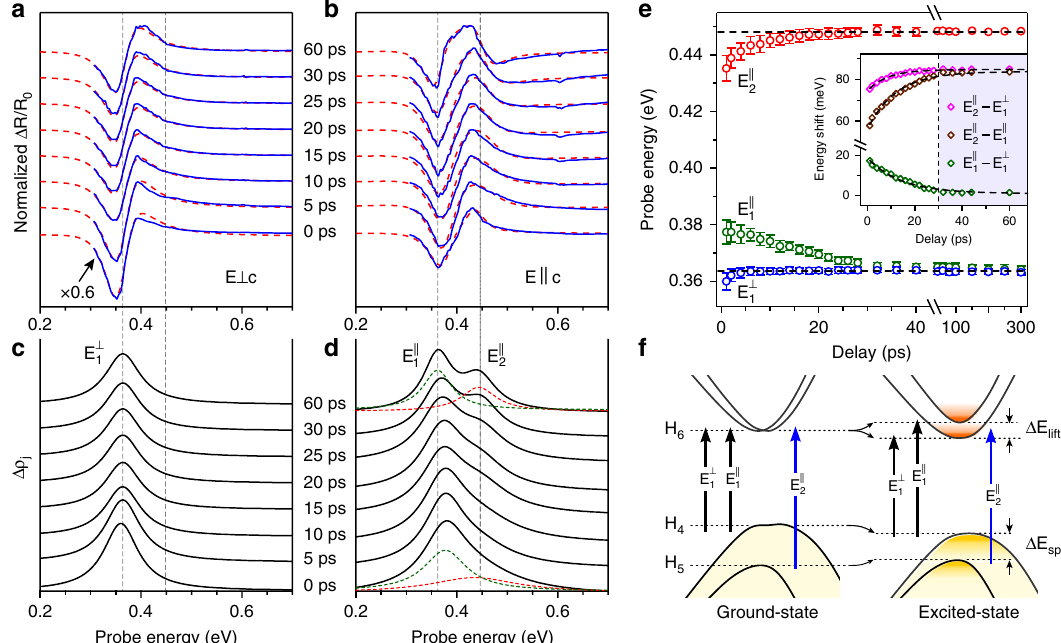
Fig. 3 Transient response of polarized optical transitions in Te nanosheet. a , b A series of selected TR spectra (blue lines) recorded at different pump- probe delay times for both E ? c and E jj c polarizations. Dashed red lines are model fi ts of each corresponding spectrum. c , d Moduli of each corresponding fi t for both polarizations. Vertical dashed gray lines are guides to the eye to indicate the systematic shift of peak position. e Transition energies E ? , E jj , and 1 1 E jj extracted from the fi ts and plotted as a function of delay for both polarizations. Error bars are estimated from the least square fi tting procedure. While 2 the E ? remains mostly stable over a long delay, the E jj , and E jj undergo gradual blue and redshifts as delay progresses before they remain steady after ~30 1 1 2 (cid:2) E ? (cid:2) E ? ps. The inset shows the time evolution of anisotropic spectral shifts, as quanti fi ed by E jj and E jj for fundamental and higher energy band-gap 1 1 1 2 (cid:2) E jj anisotropy and E jj for the gap between uppermost VBs excluding the doping induced Fermi energy shift. Superimposed dashed lines on each curve are 1 2 exponential fi ts for a guide to the eye. The shaded region is shown to indicate the static region. f Ground-state and photoinduced band structure (note exaggerated energy scales) around the H-point near the band gap, showing photoinduced lifting Δ E lift of the H CB band and narrowing of the gap Δ E sp 6 between the uppermost VBs. The involved optical transitions are indicated by vertical